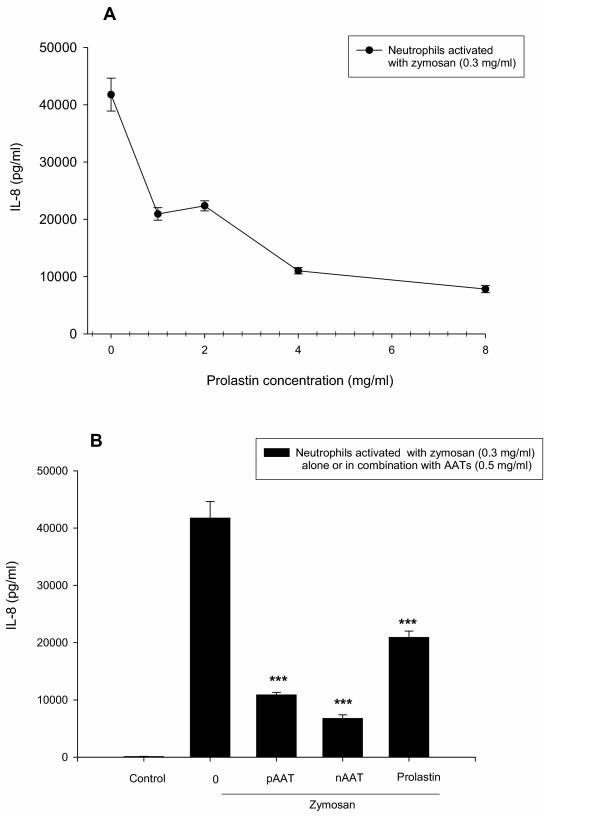
Effects of AATs on neutrophils activated with zymosan. (A) Concentration-dependent effects of Prolastin on IL-8 release from neutrophils activated with opsonised zymosan. Freshly isolated blood neutrophils were treated with zymosan (0.3 mg/ml) alone or together with various concentrations of Prolastin (0–8 mg/ml) for 18 h. IL-8 levels were measured by ELISA. Data are the means of quadruplicate culture supernatants ± S.E. and are representative of three separate experiments. (B) Effects of opsonised zymosan alone or together with native (nAAT), polymeric (pAAT) AAT or Prolastin on IL-8 release from neutrophils. The release of neutrophil IL-8 was measured in cell free supernatants as described in Materials and methods. Neutrophils were treated for 18 h with a constant amount of zymosan (0.3 mg/ml) alone or together with nAAT, pAAT or Prolastin (0.5 mg/ml) for 18 h. IL-8 levels were measured by ELISA. Each bar represents the means ± S.E. of three separate experiments carried out in duplicate repeats. *** p < 0.001